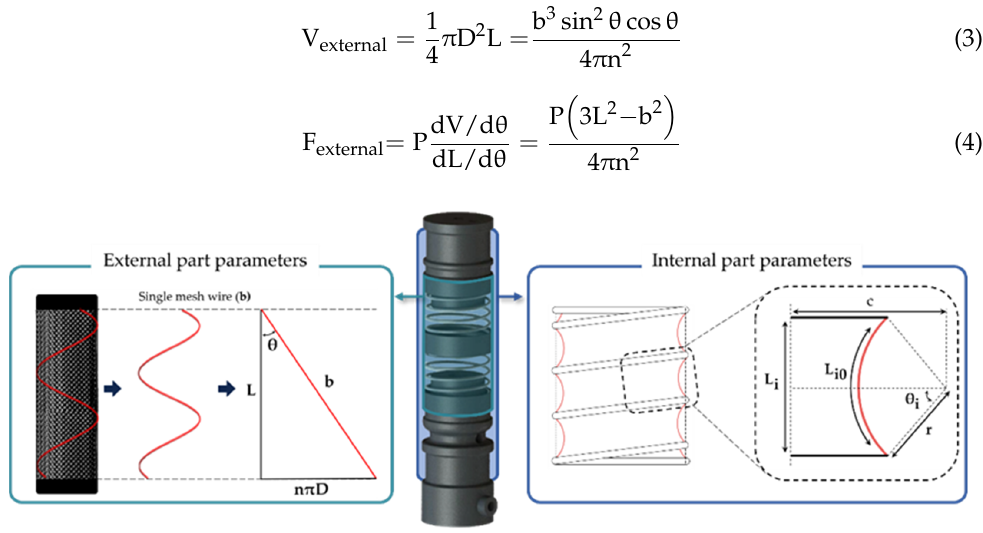
Figure 3. Modeling parameters of the external part and internal part.